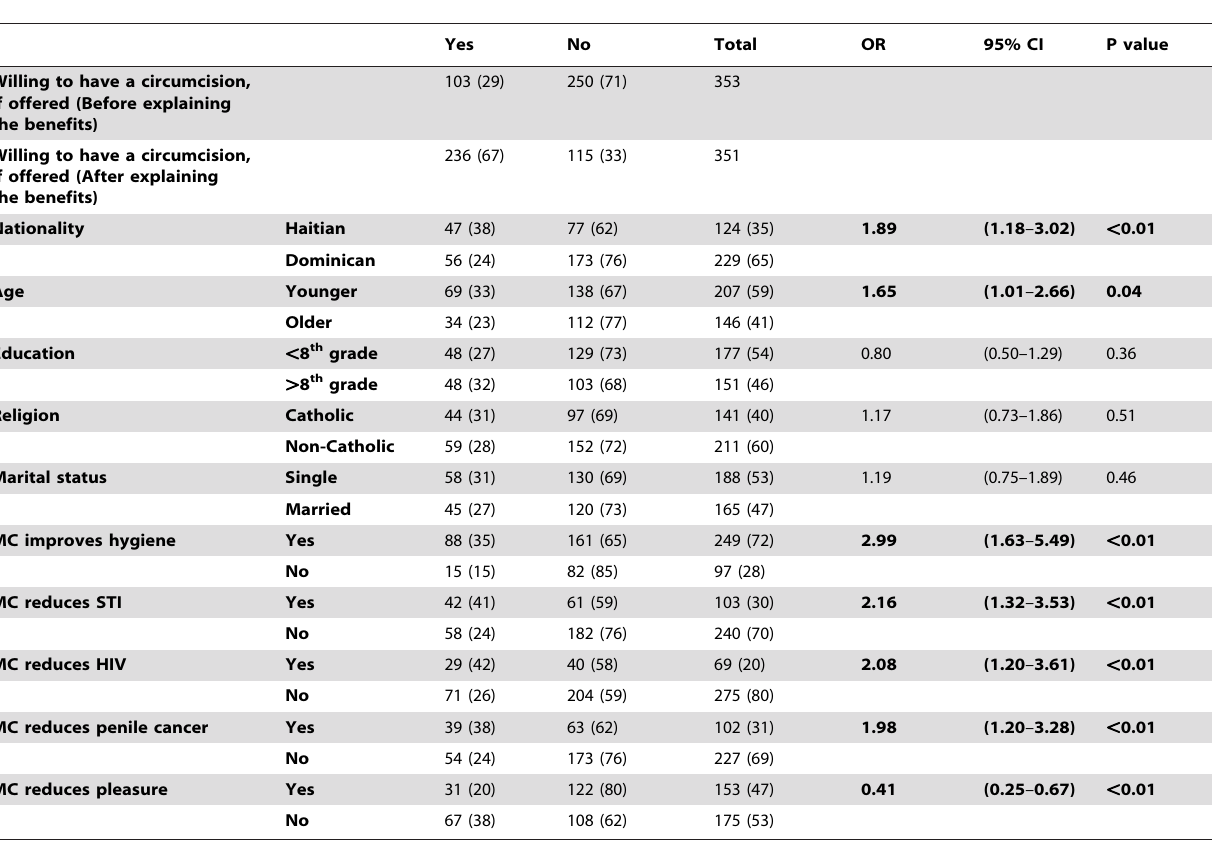
Table 3. Willingness to be circumcised by demographic characteristics and perceived benefits of the procedure (unadjusted